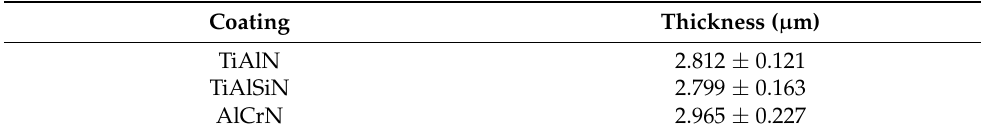
Table 5. Average thickness values for the analyzed